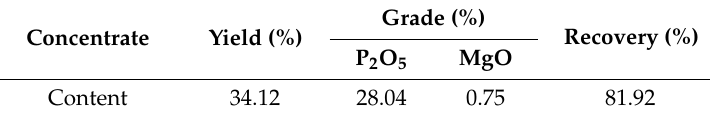
Figure 6. The rougher flotation flowsheet. Table 3. The flotation result of P 2 O 5 under the optimal flotation conditions by X-ray fluorescence (XRF) analysis.